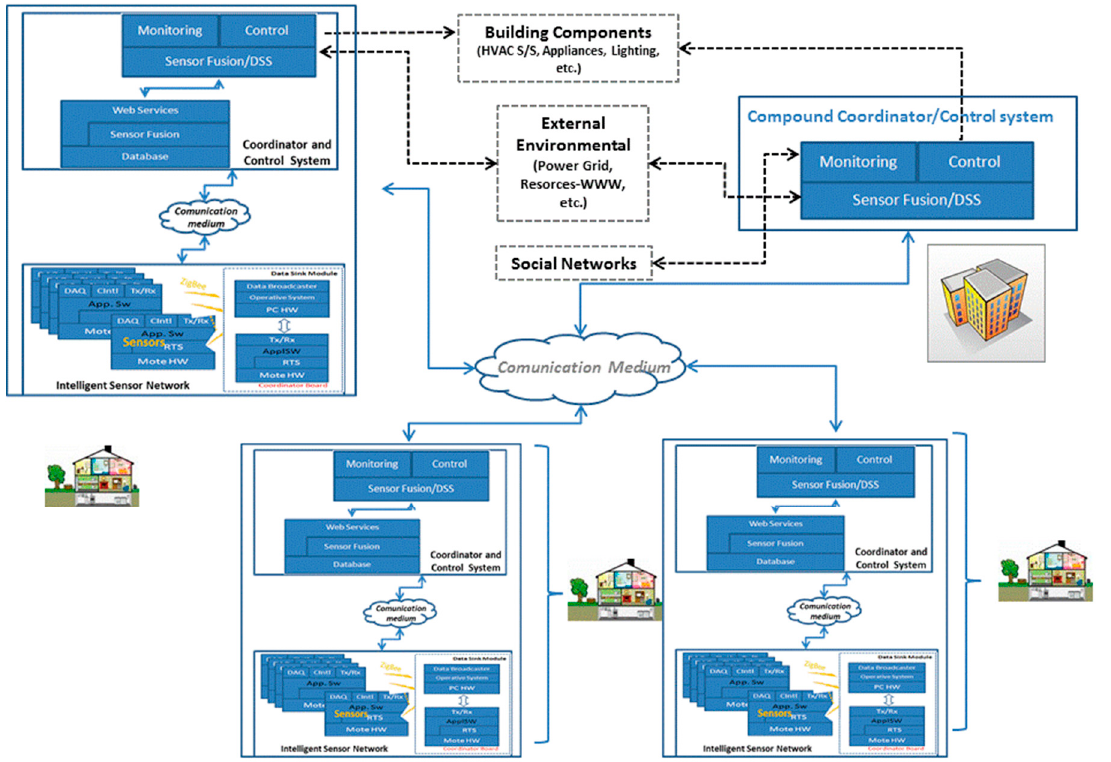
Figure 2. The architecture of the proposed pervasive energy usage monitoring system discussed in [14]. It has been shown that pervasive and continuous power monitoring in households allows energy savings between 10% and 15% to be achieved.